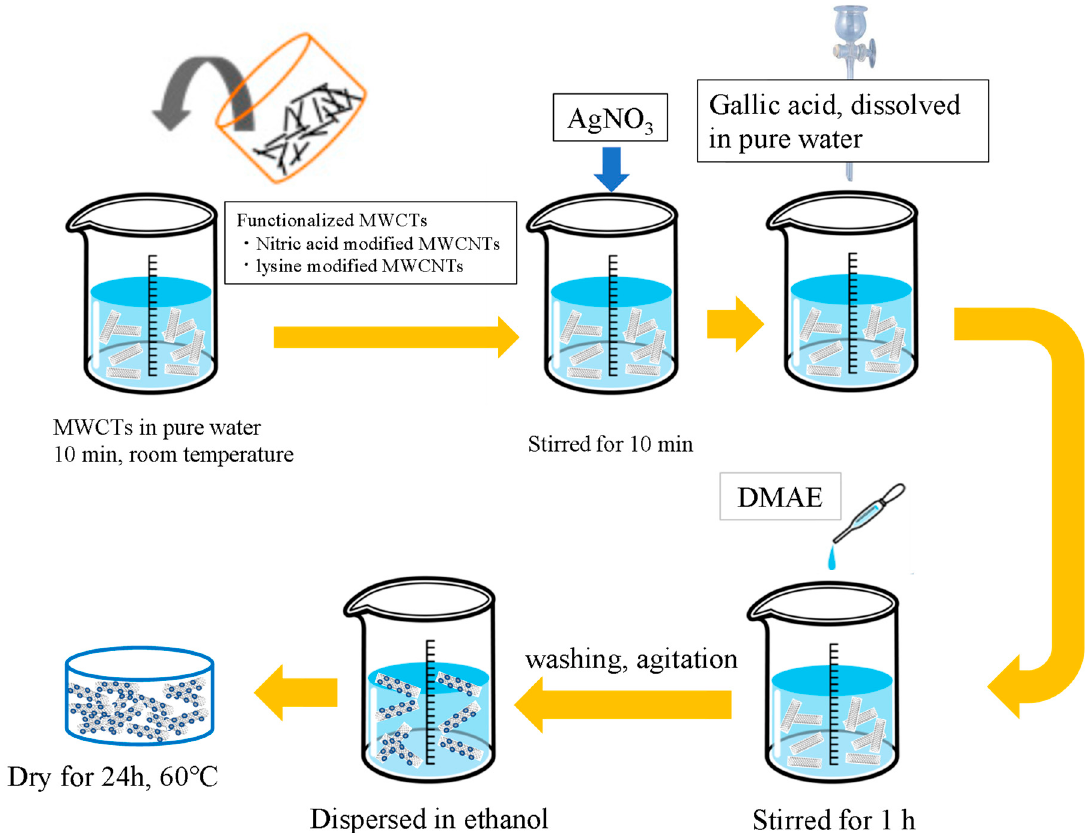
Figure 1. Fabrication process of AgNP/MWCNT nanocomposites.